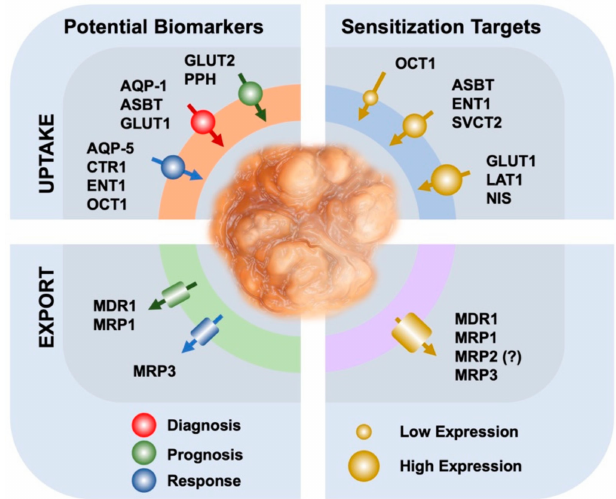
Figure 1. Schematic representation of the role in cholangiocarcinoma of uptake (up) and export (down) transporters as biomarkers for diagnosis and prediction of response to chemotherapy (left) or as targets for strategies of chemosensitization to antitumor drugs (right). Aquaporin-1 / 5 (AQP-1 / 5); apical sodium-dependent bile acid transporter (ASBT); cooper transporter (CTR1); equilibrative nucleoside transporter 1 (ENT1); glucose transporter 1 / 2 (GLUT1 / 2); L-type amino acid transporter-1 (LAT1); multidrug resistance protein 1 (MDR1); multidrug resistance-associated protein 1 / 3 (MRP1 / 3); sodium–iodide symporter (NIS); organic cation transporter 1 (OCT1); Phosphohippolin (PPH); sodium-dependent vitamin C transporter 2